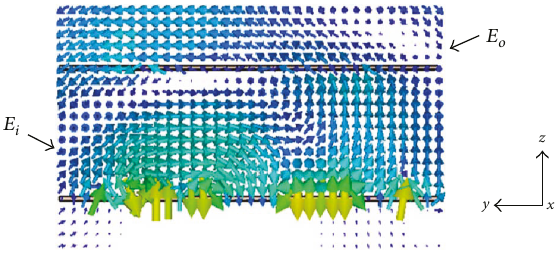
Figure 7: E- fi eld on reference antenna with WBLHM layer.